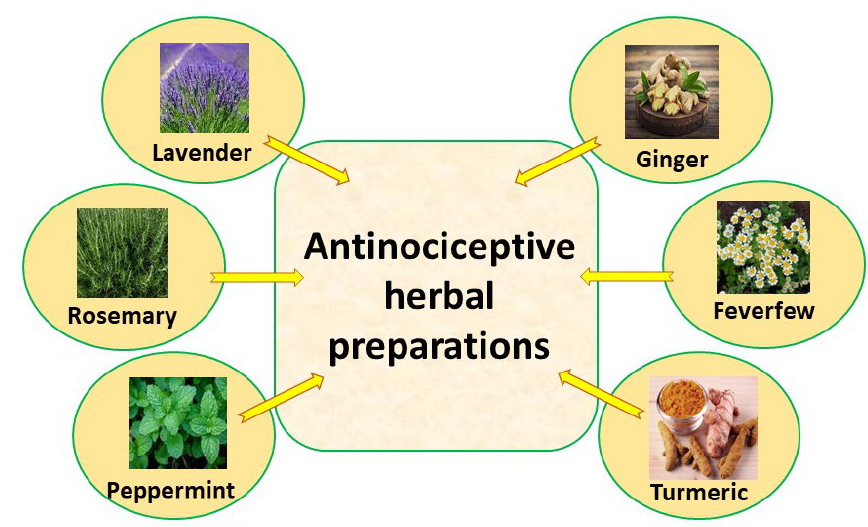
Figure 3. Main herbs exerting antinociceptive activity.